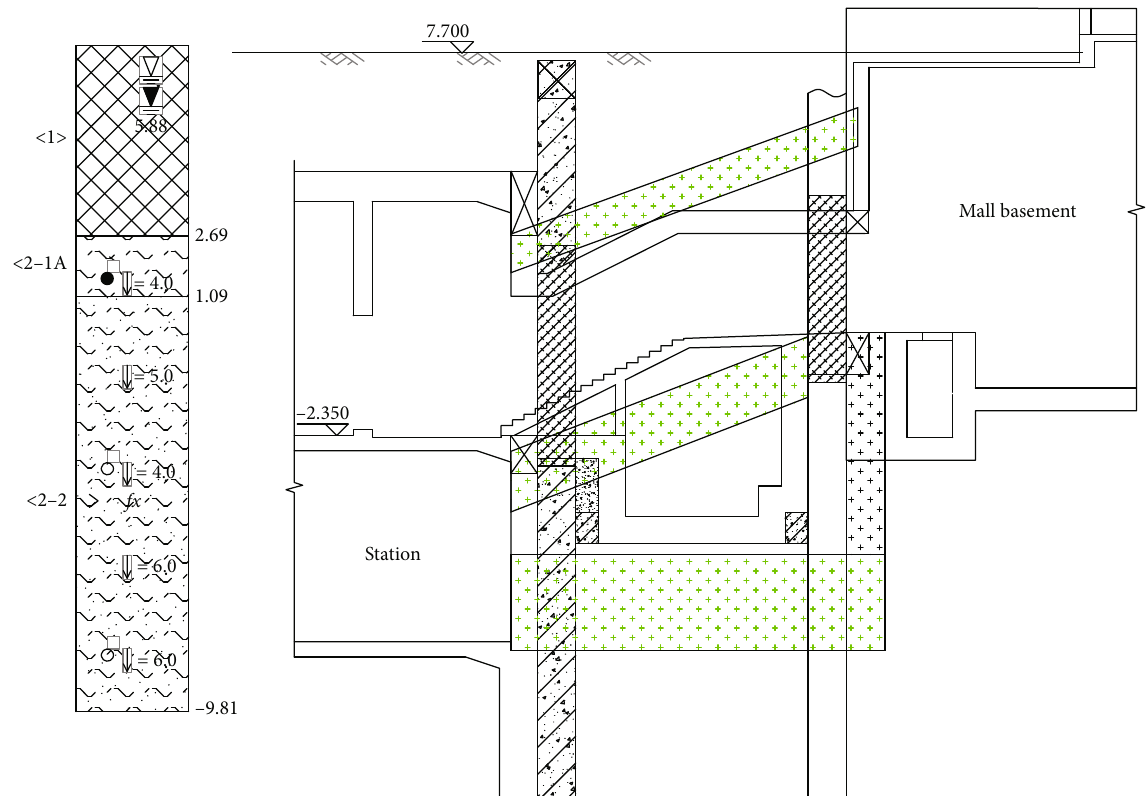
Figure 1: Design of freezing project and geological